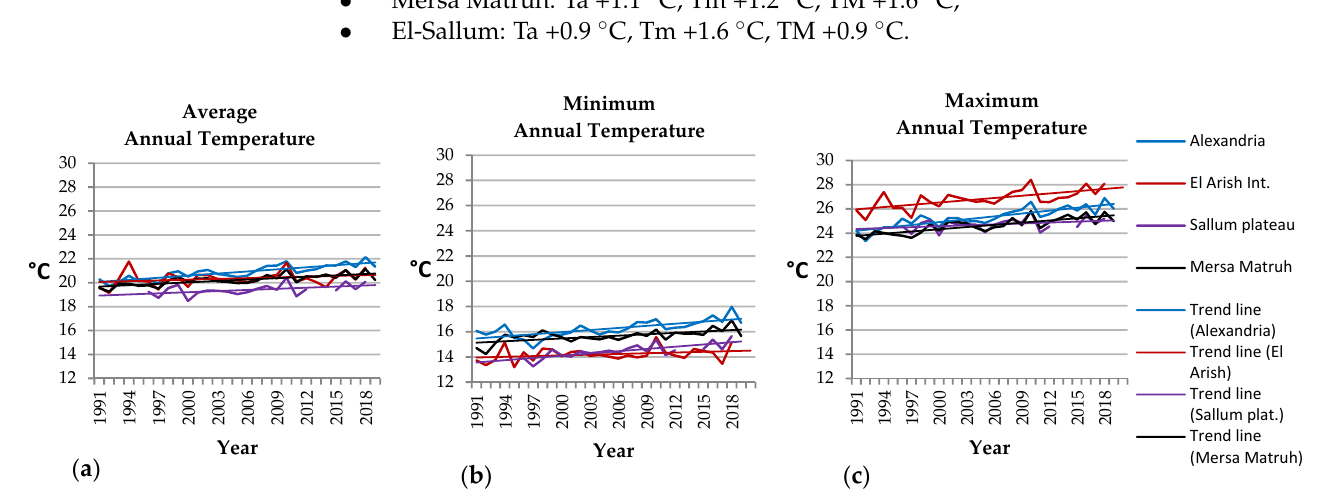
Figure 3. ( a – c ) Average annual temperature ( a ), minimum temperature ( b ), maximum temperature ( c ); the trend lines were obtained through Sen slope estimator from 1991 to 2020 in El Arish, Alexandria, Mersa Matruh, and El-Sallum.